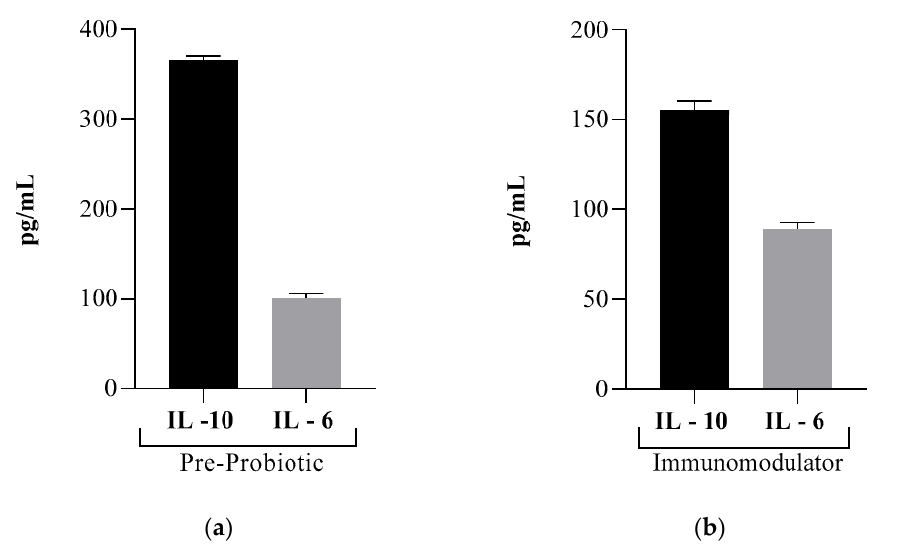
Figure 4. The ratio of IL-6 to IL-10 for the novel formulated products; ( a ) Pre-Probiotic; ( b ) Im- Figure 4. TheratioofIL-6toIL-10forthenovelformulatedproducts; ( a )Pre-Probiotic; ( b munomodulator.